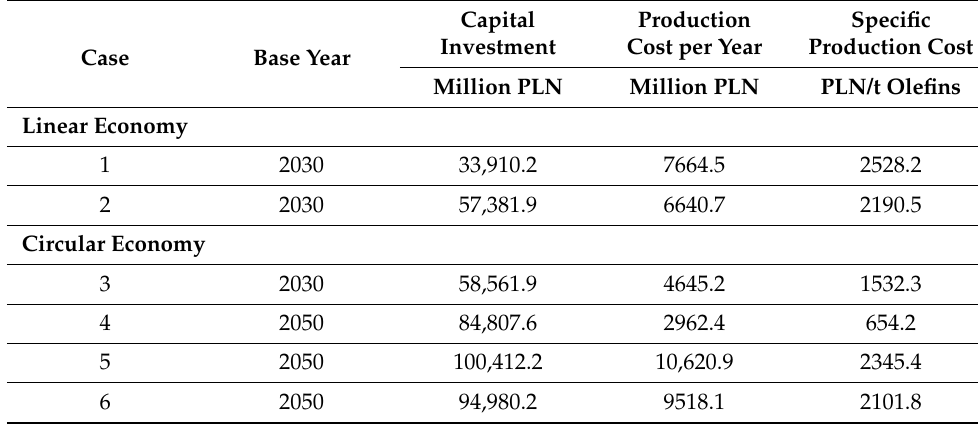
Table 10. Capital investment and production cost comparison for analyzed cases.